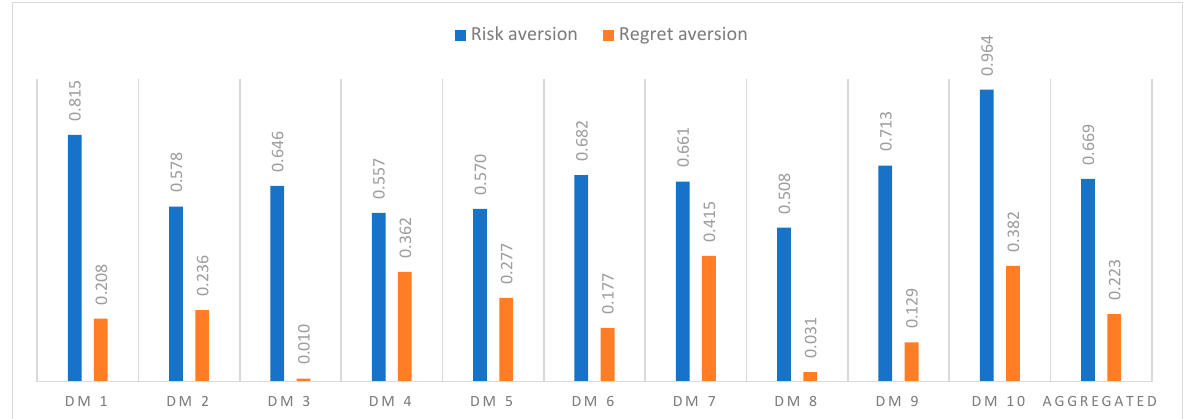
Figure 4. Psychological behavior coefficients of decision-makers. Processes 2022 , 10 , 2732 Figure 3. Decision-makers’ weighting results. Figure 3. Decision-makers’ weighting results.